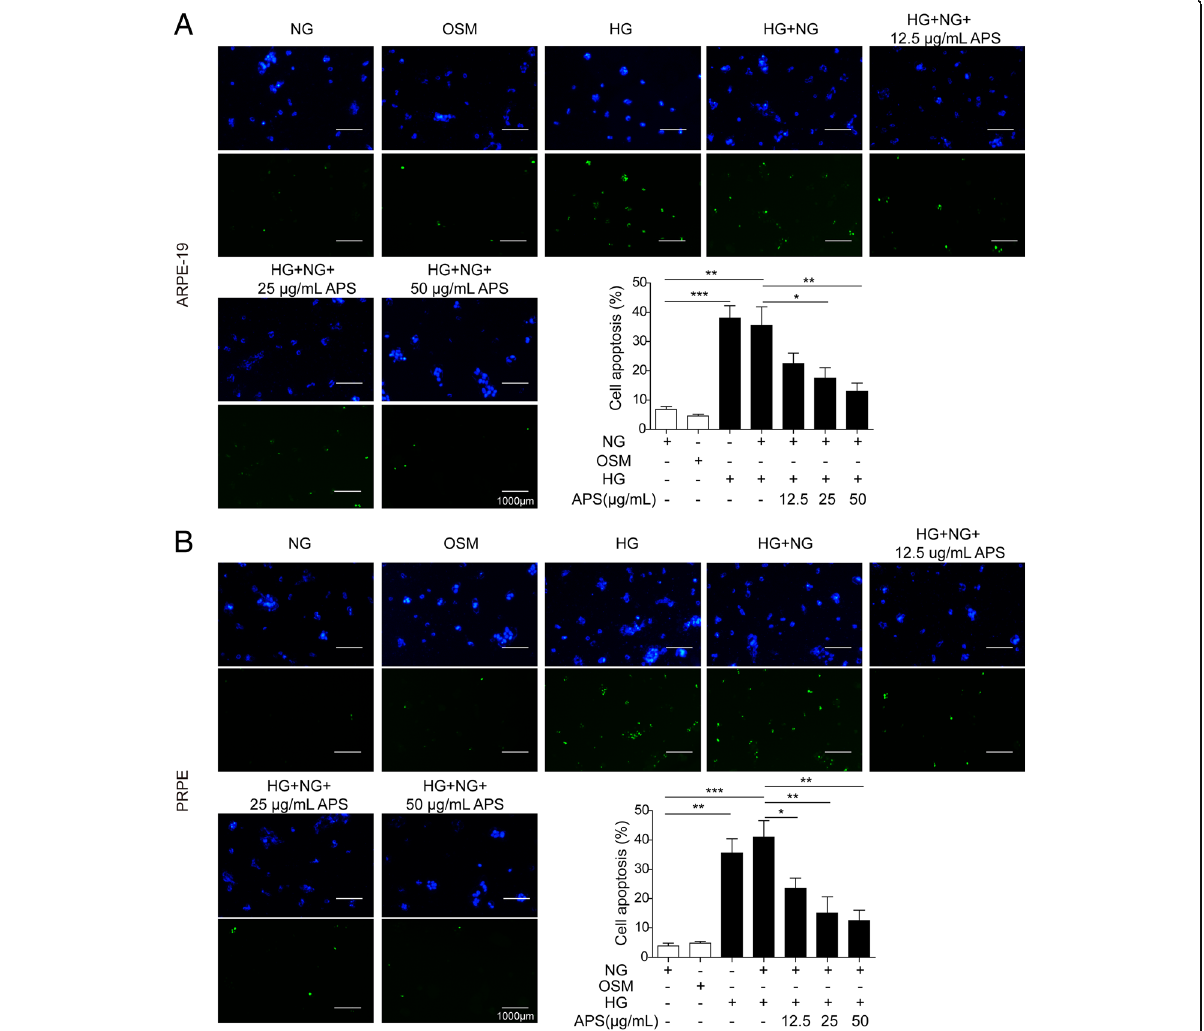
Fig. 7 APS rescued the apoptosis in metabolic memory model by TUNEL staining. a TUNEL staining showed treatment with APS significantly decreased the TUNEL positive cells induced by HG and HG + NG treatment in APRE-19 cells. b TUNEL staining showed treatment with APS significantly decreased the TUNEL positive cells induced by HG and HG + NG treatment in PRPE cells. Error bars represented mean ± SD. *** p < 0.001, ** p < 0.01, * p <